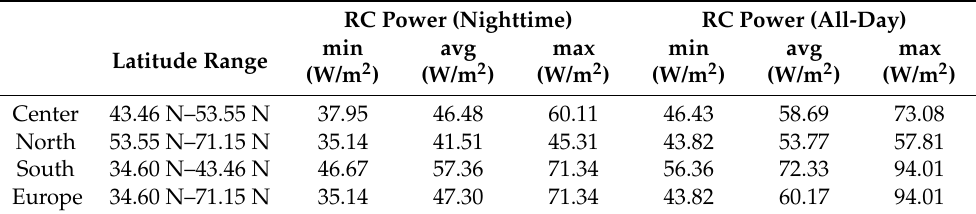
Table 1. Minimum, average and maximum annual average power potential of the different zones of Europe. RC Power (Nighttime) RC Power (All-Day) min Latitude Range (W/m 2